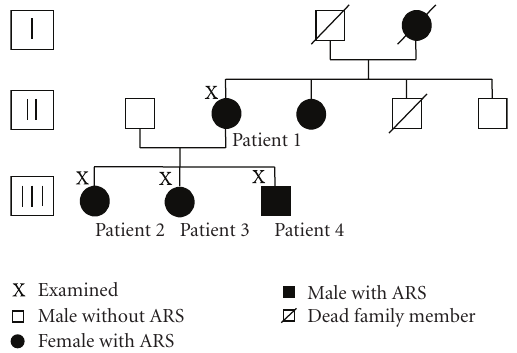
Figure 1: Three-generation pedigree of the reported family.